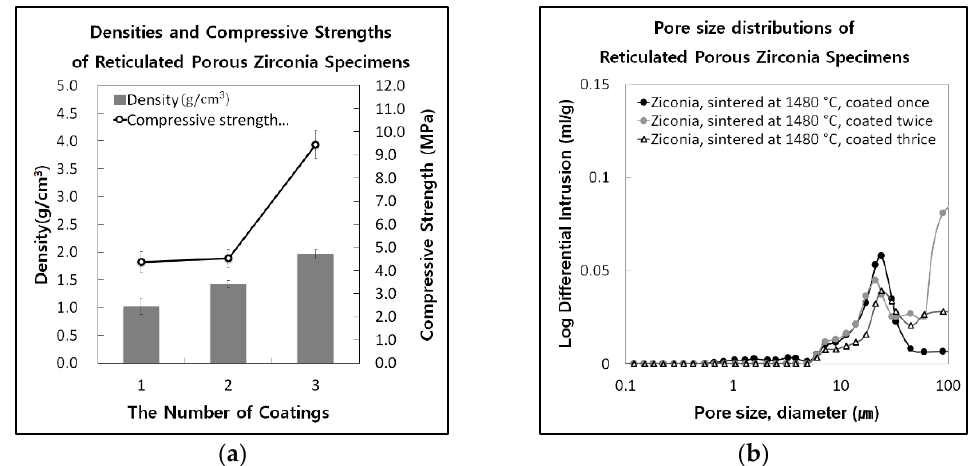
Figure 9. ( a ) Densities and compressive strength outcomes, and ( b ) pore size distributions when increasing the number of coatings of reticulated porous zirconia.